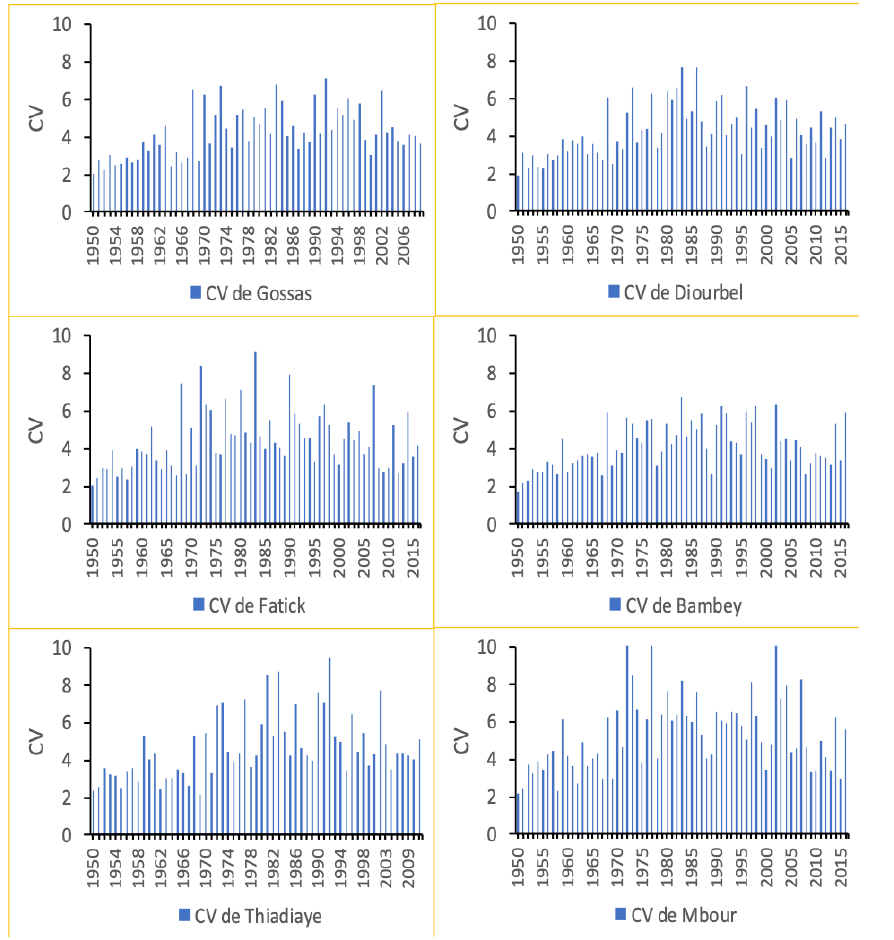
Figure 3. Evolution of the coefficient of variation for the 6 studied rainfall stations, from 1950 to 2009 for Gossas, from 1950 to 2011 for Thiadiaye, and from 1950 to 2016 for Bambey, Fatick, Diourbel and Mbour.